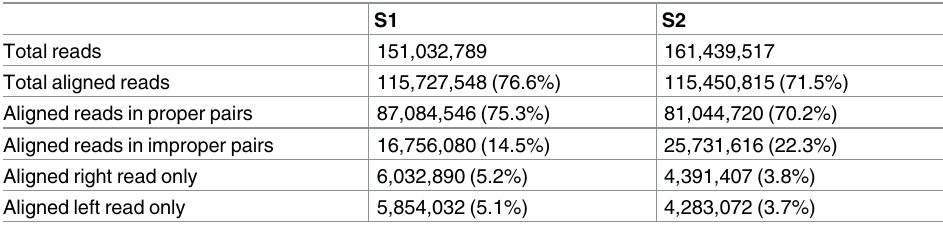
Table 2. RNA-Seq read alignment statistics.